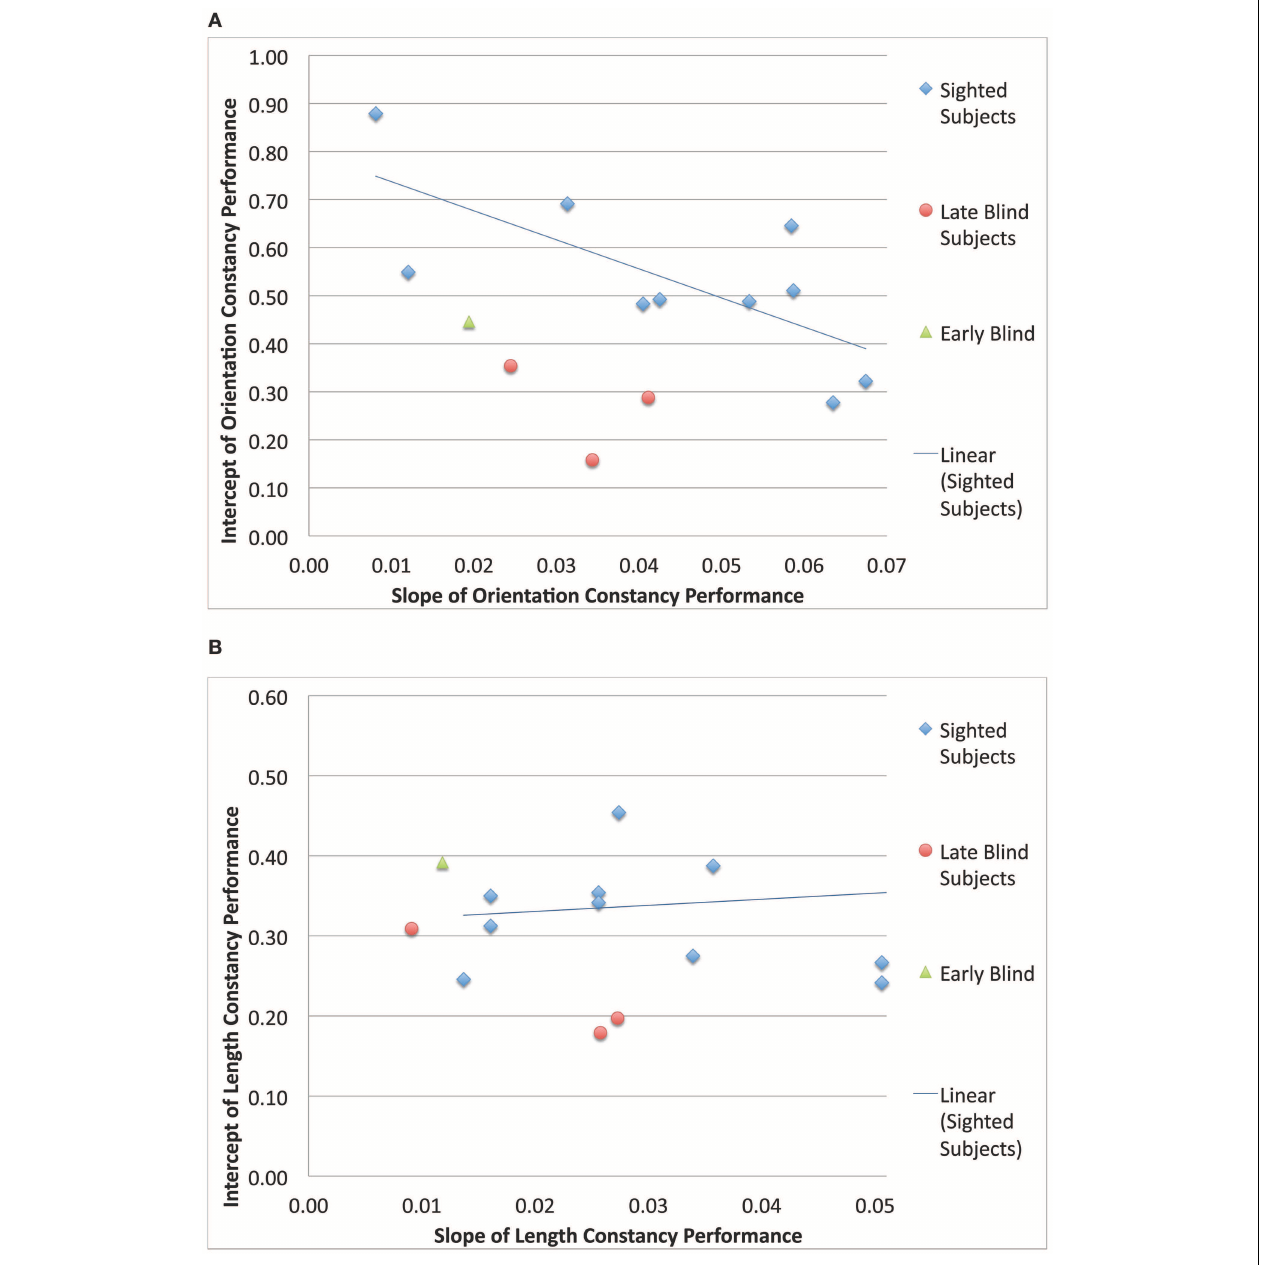
FIGURE 6 | A comparison between blind and sighted group performance. The intercepts and slopes (from the performance as a function of time plots) for each subject are scatter plotted for orientation constancy (A) and for length constancy (B) .